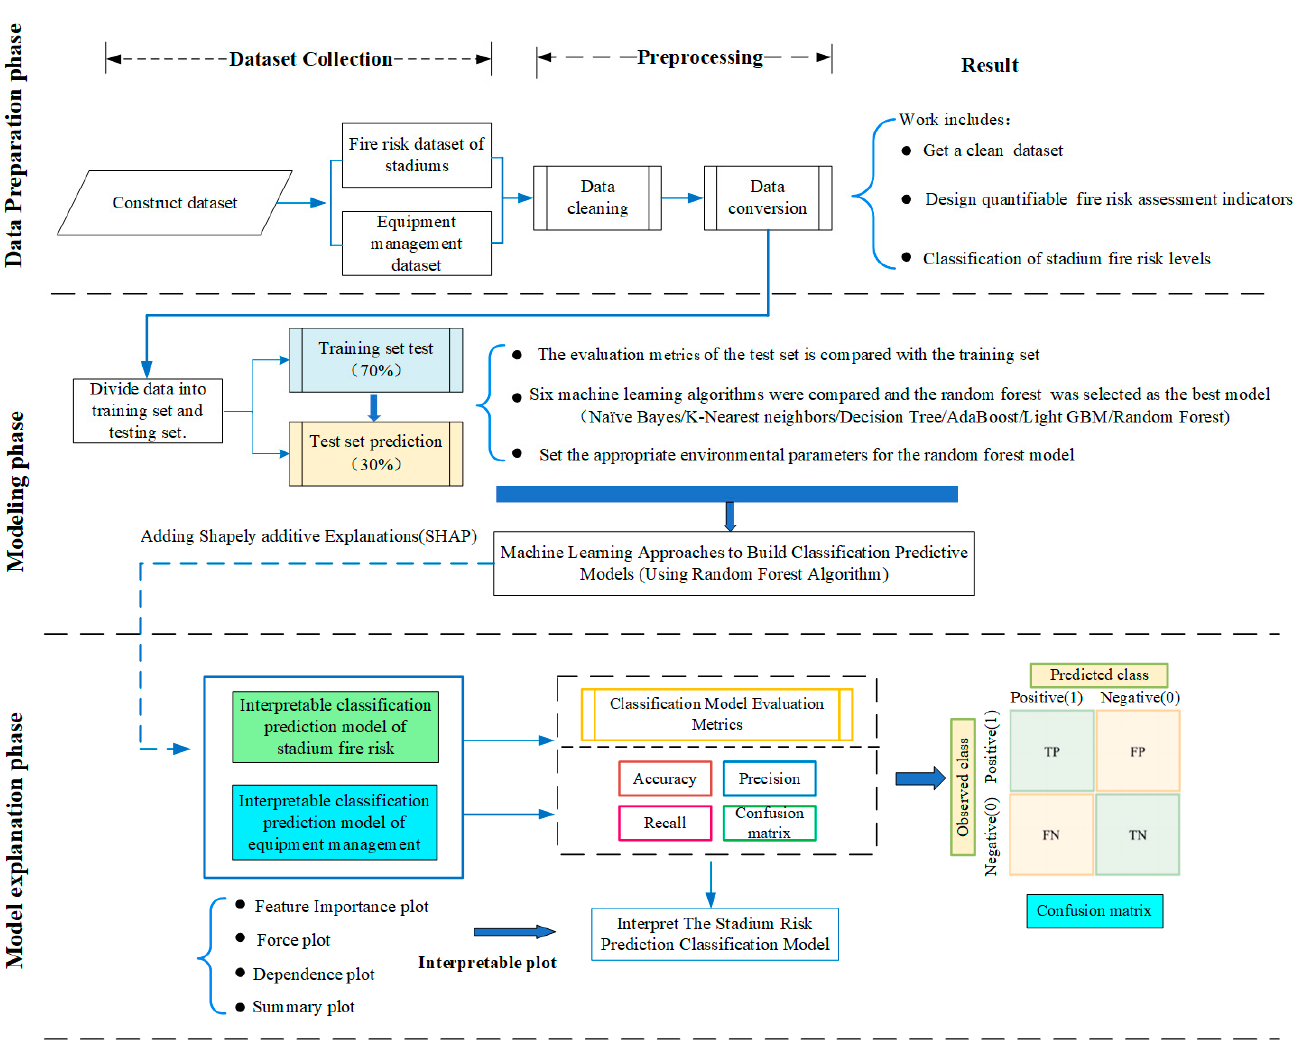
Figure 2. The key process using SHAP for an interpretable machine learning model.